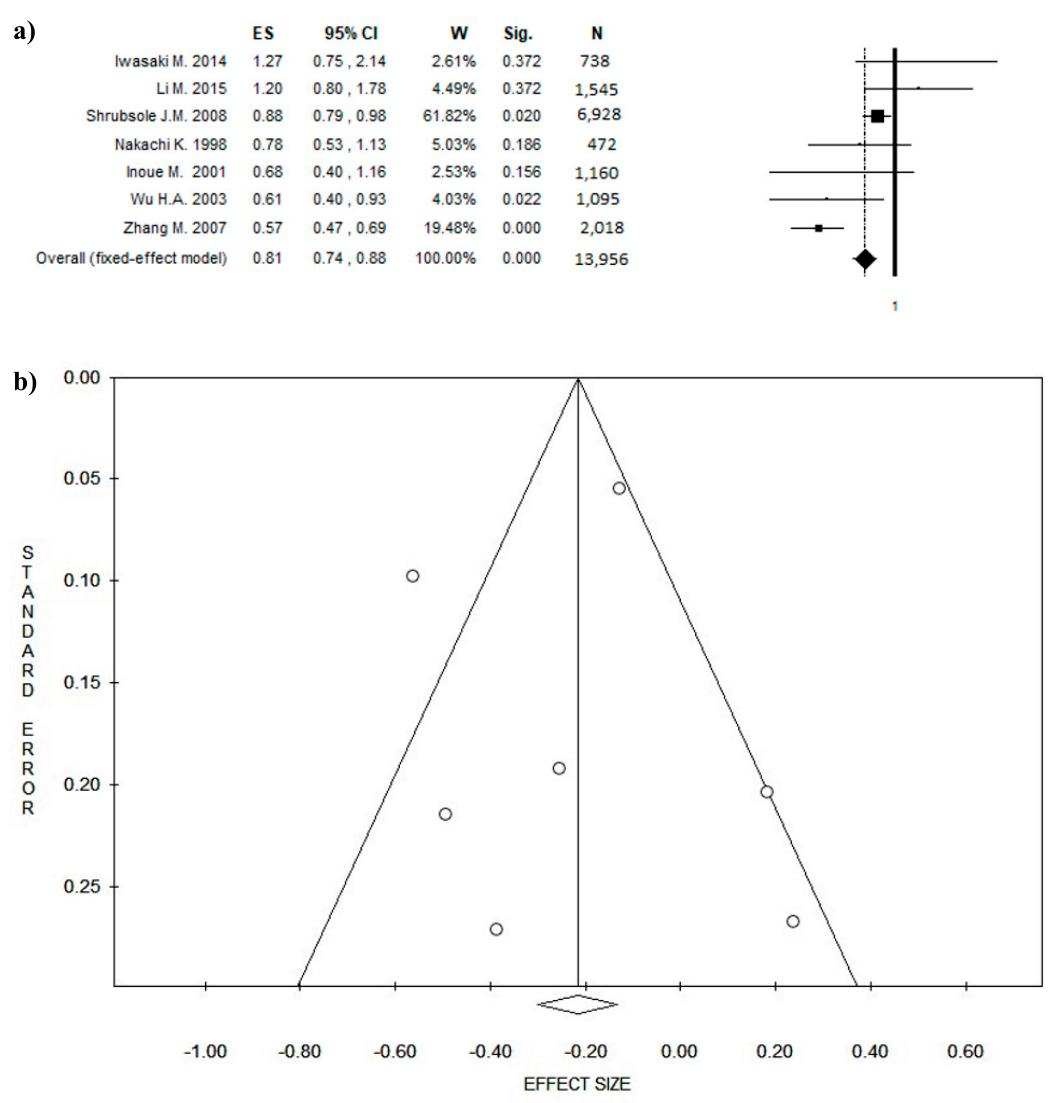
Figure 4. Forest plot ( a ) of the meta-analysis comparing green tea consumption in breast cancer (BC) recurrence. Funnel plot ( b ). Abbreviations: ES = effect size; CI = confidence interval; W = weight; Sig = significance; N = number.